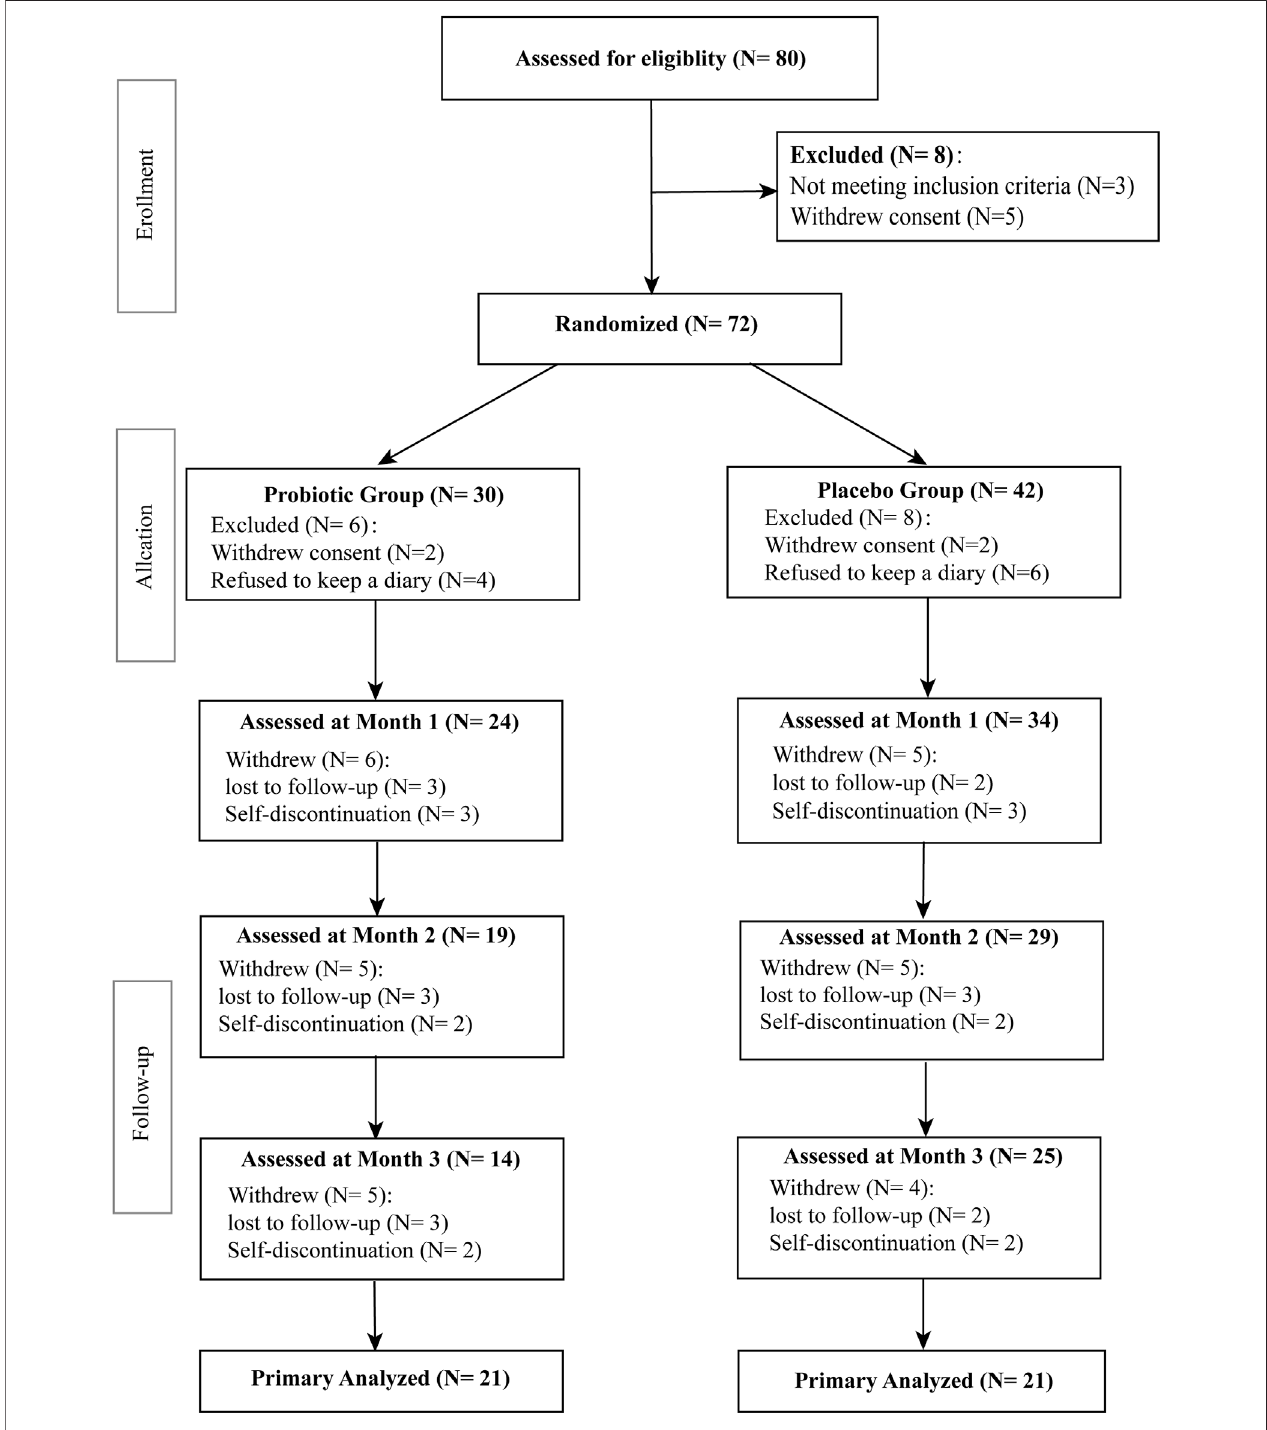
FIGURE 1 | Flow chart indicating the recruitment of bipolar patients.